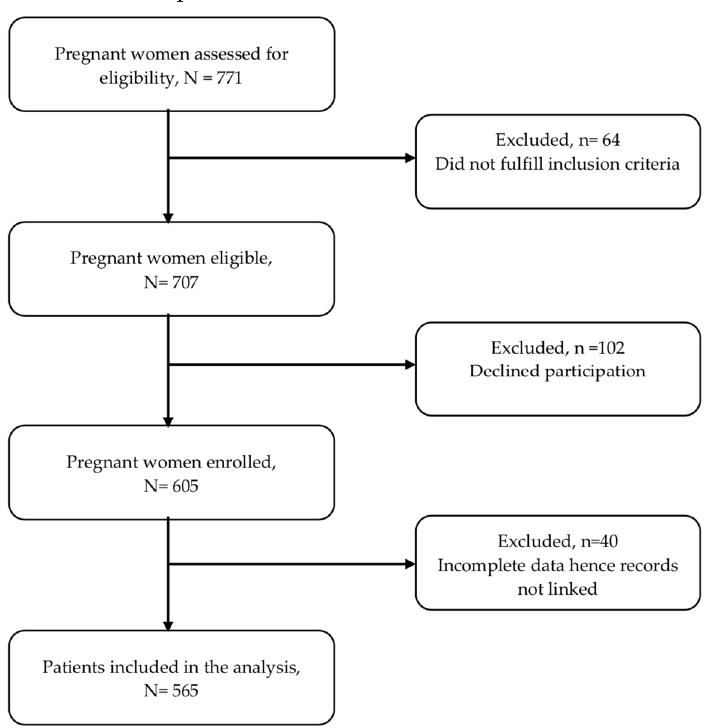
Figure 1. Flow chart of included and excluded participants.